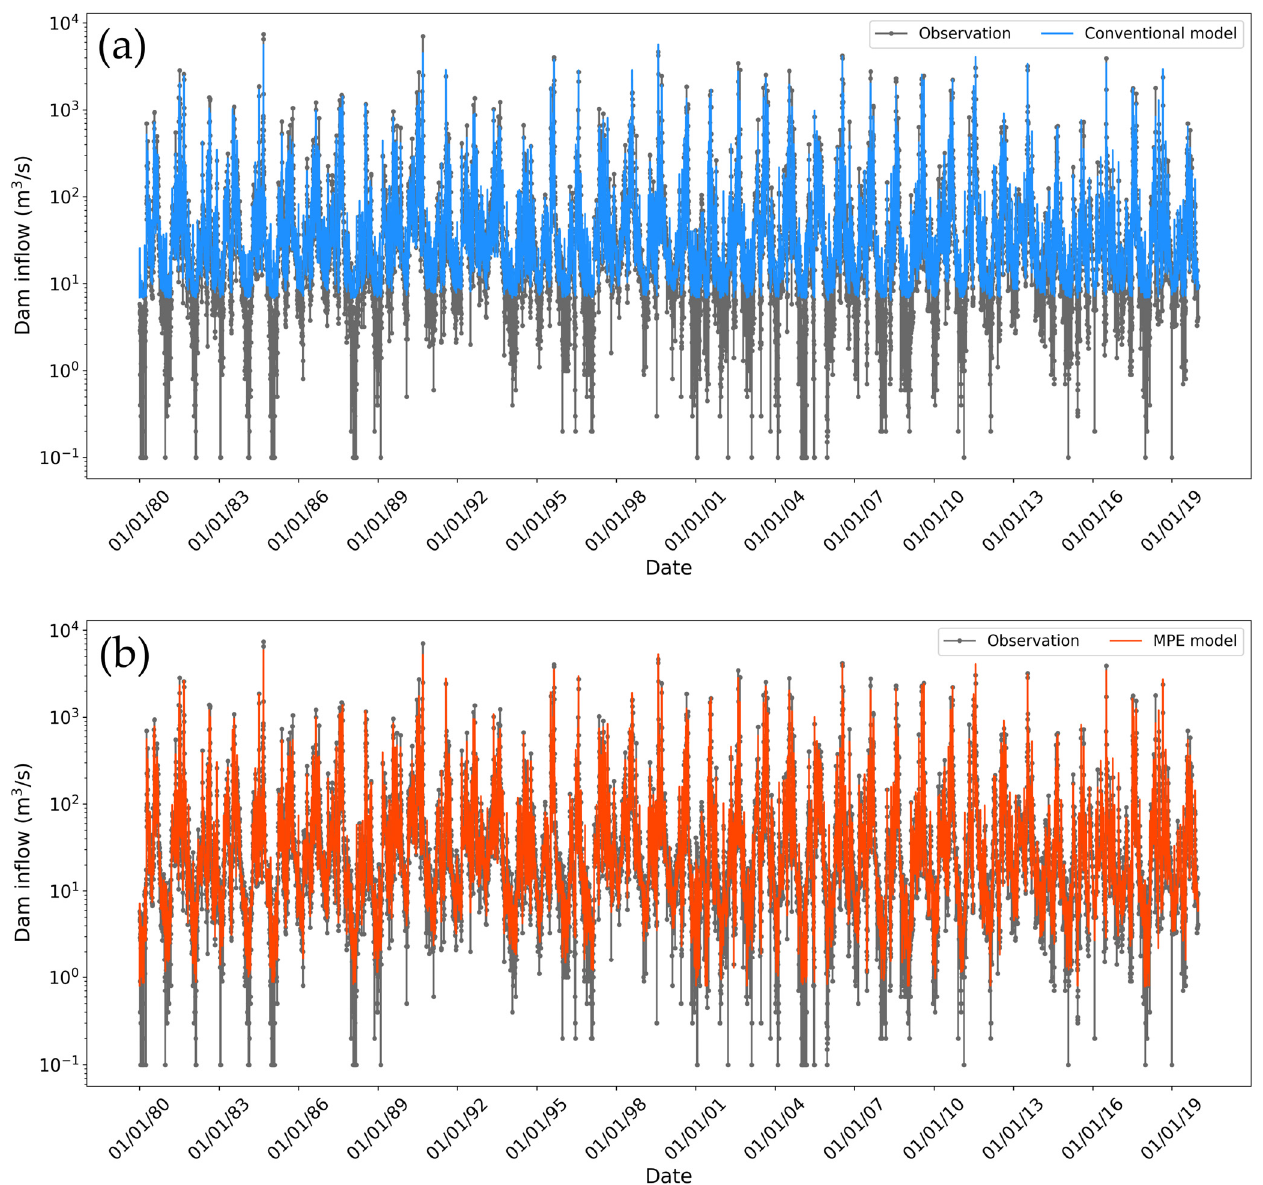
Figure 6. Comparison of predicted and observed inflow using both models with training ( a ) and test ( b ) data. Table 3. Comparison of performance of both models on training and test data.